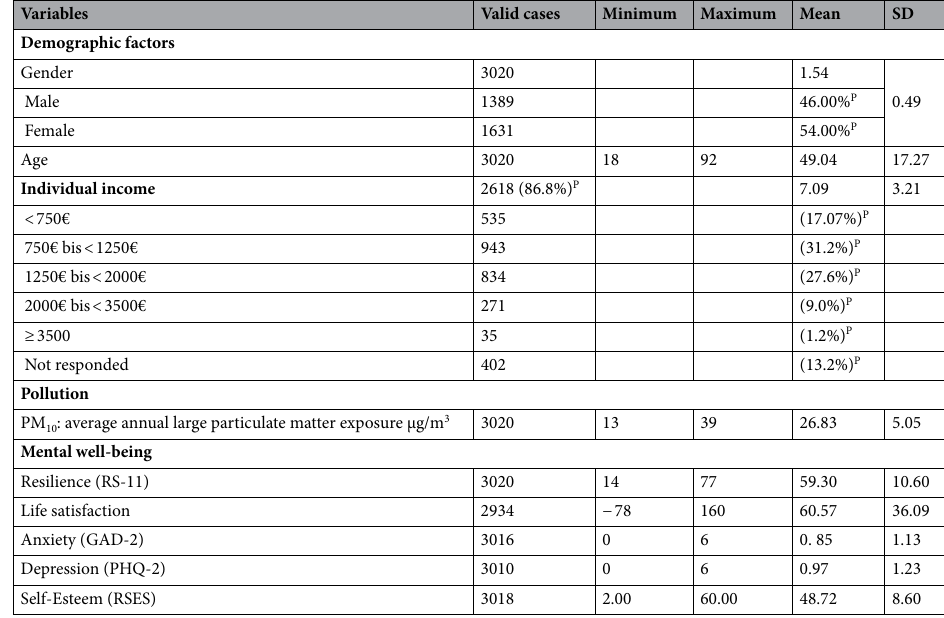
Table 1. Study variables and descriptive statistics. SD standard deviation, P percentage of total sample or sub sample, RS resilience scale 11-items, GAD General Anxiety Disorder 2-items, PHQ-2 Patient Health Questionnaire 2-items, RSES Rosenbergs’s Self-Esteem Scale.